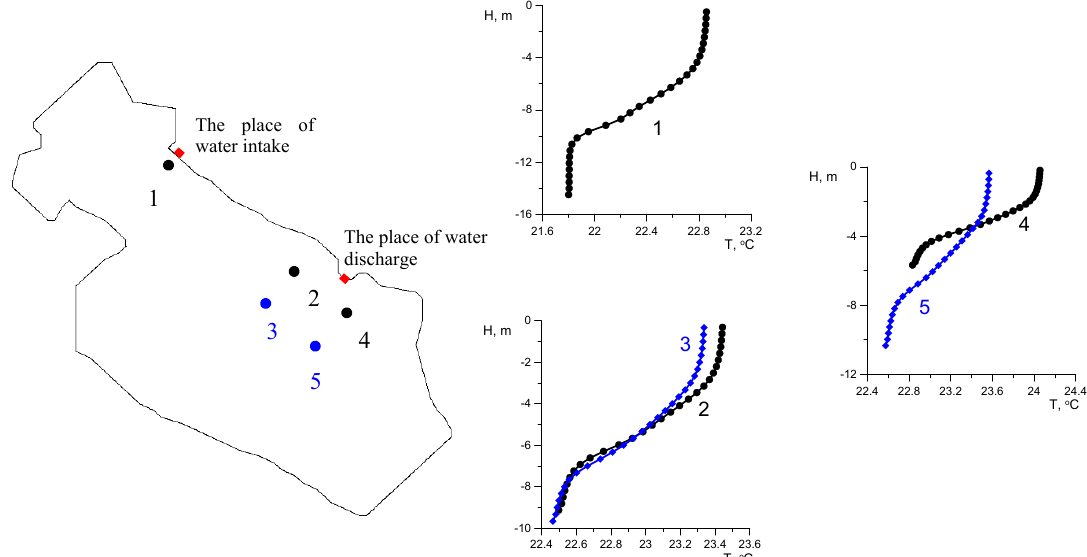
Figure 12. The temperature distributions in depth at different verticals for calm conditions at t = 97 hours.